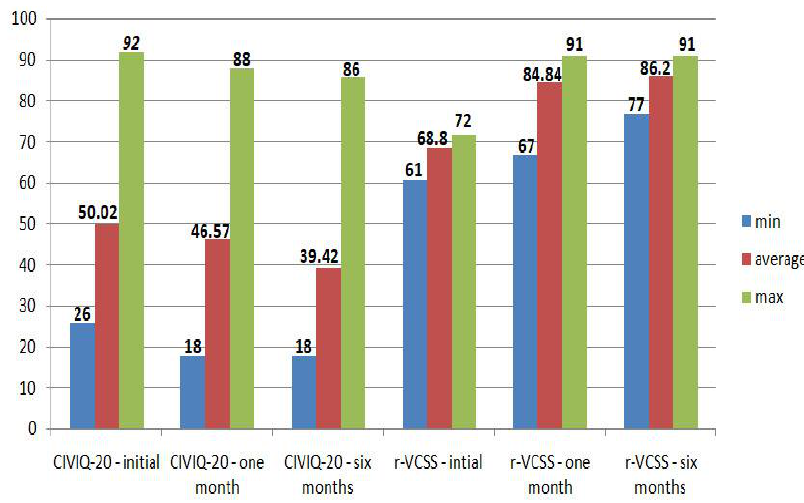
Figure 1. CIVIQ-20 and r-VCSS results at baseline, one month, and six months among the study group.